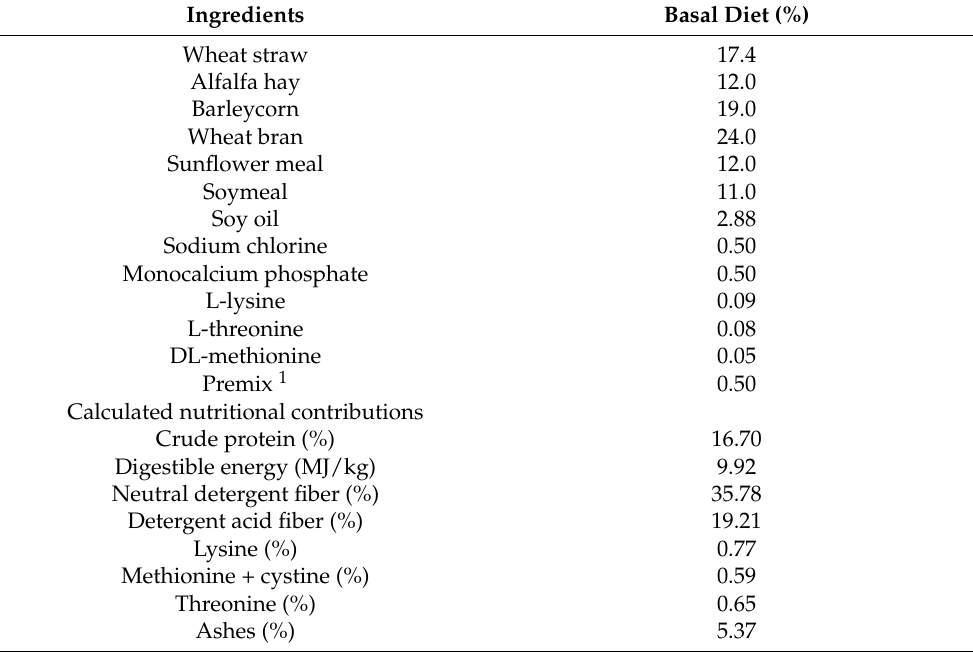
Table 1. Ingredients and nutritional contributions of the diet for broiler rabbits (35 to 95 days